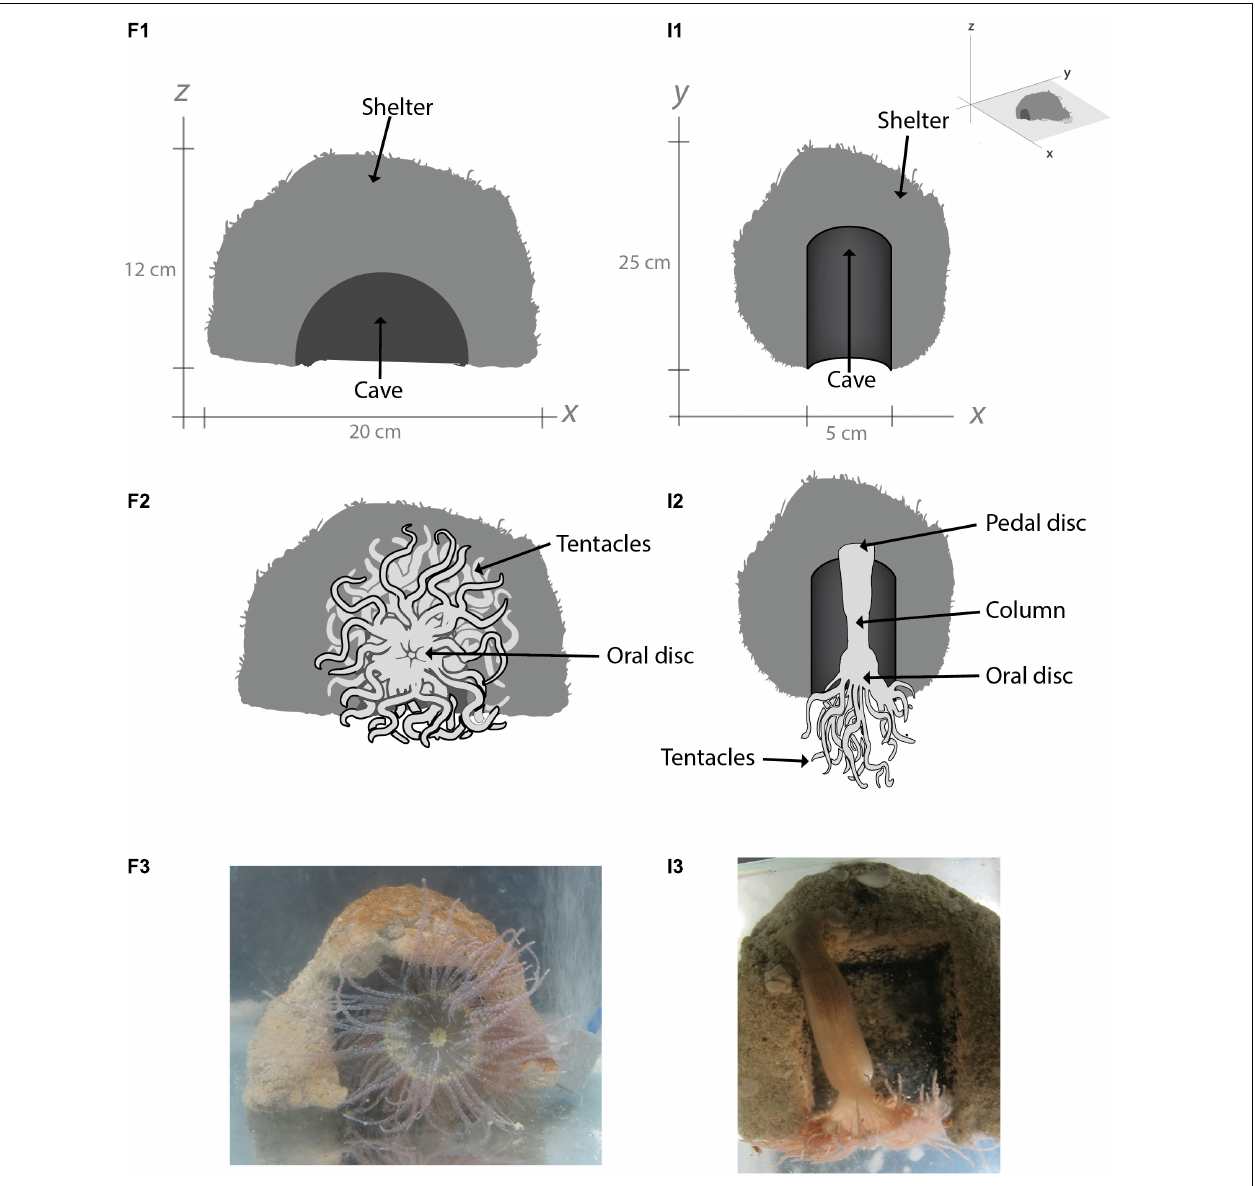
FIGURE 3 | Diagrams of artificial shelters made of a mixture of sand and cement for anemones to attach and find refuge. View from the front with (F1) and without an anemone (F2) ; view from the interior gallery with (I1) and without an anemone (I2). Photographic registers of the frontal (F3) and interior (I3) views of the artificial shelter holding a Bartholomea annulata during